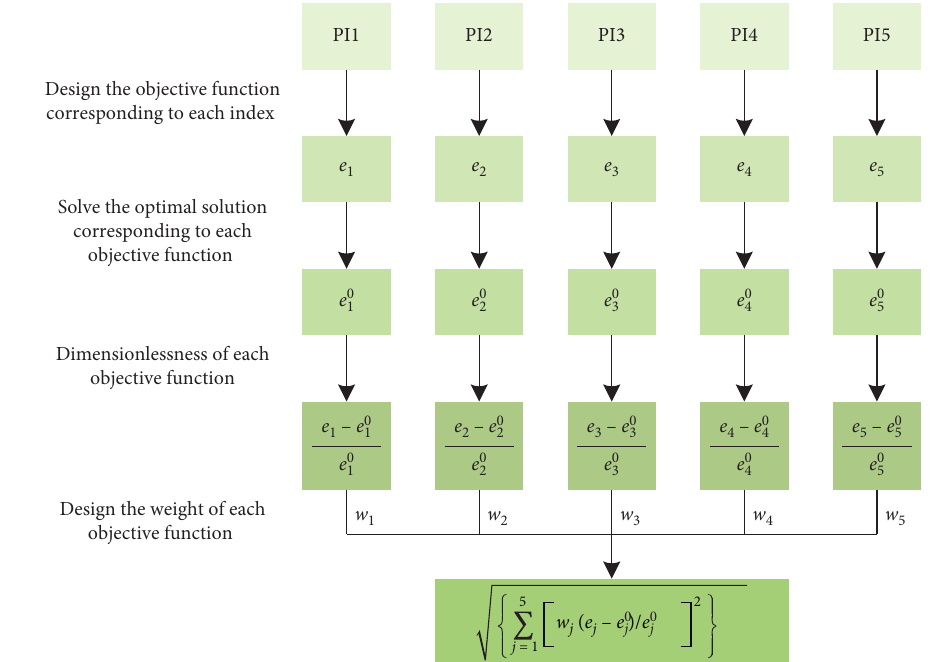
Figure 7: The design of parameter allocation objective